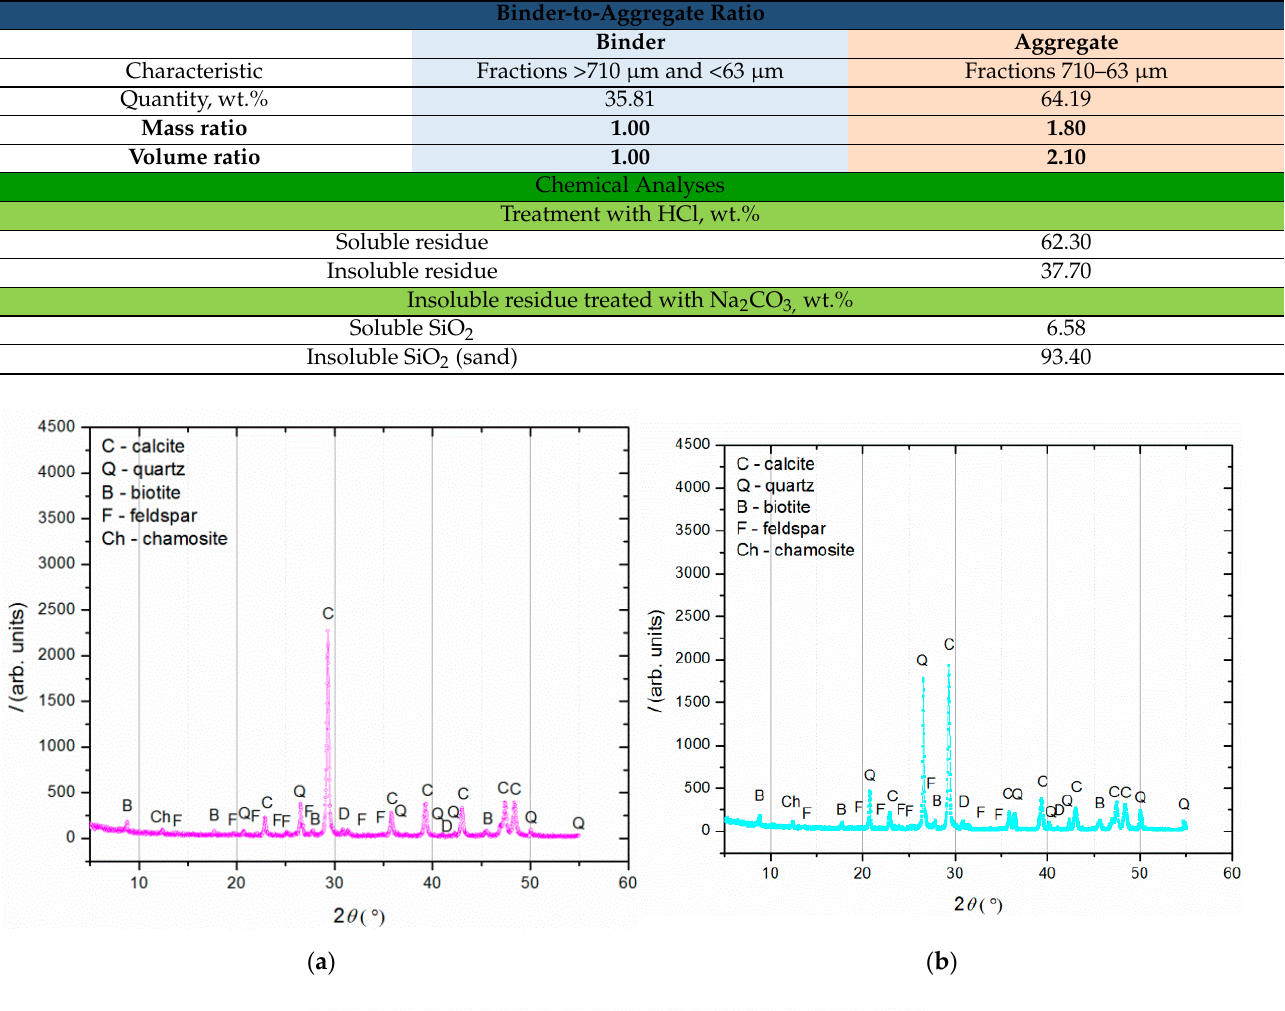
Table 3. Binder-to-aggregate ratio and chemical analyses of historical mortar sample, HM.